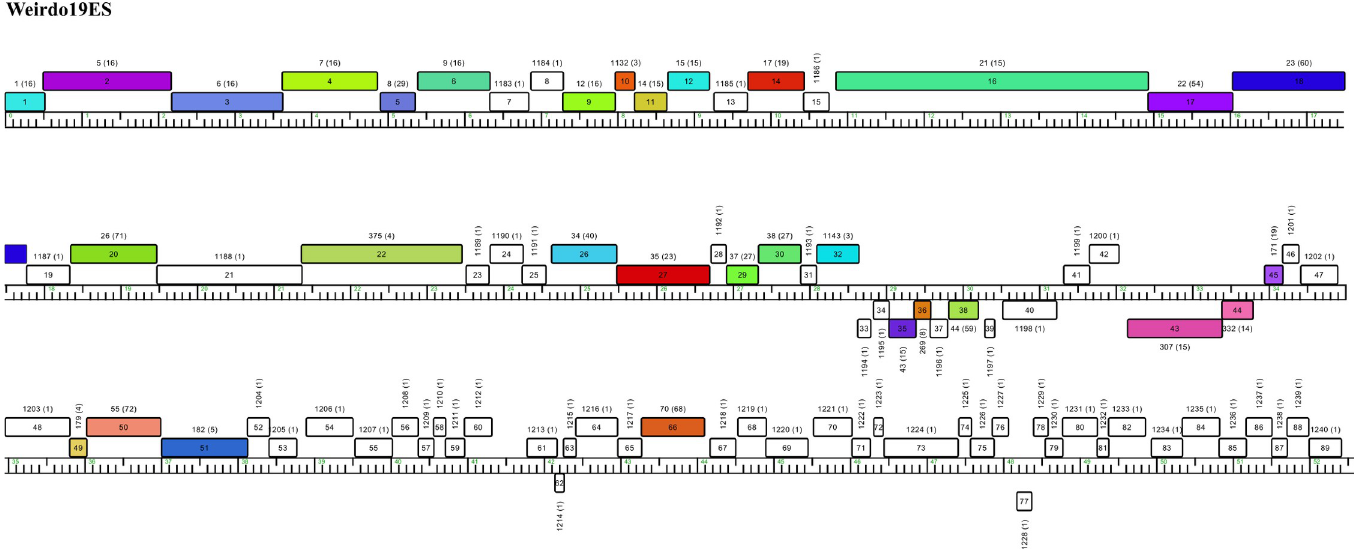
Fig 1. Weirdo19ES genome map. This map was generated by Phamerator, the colors of the gene indicate the assigned pham, orphans are shown in white. The pham numbers are above the boxes, whereas the number of the pham members are indicated between brackets.